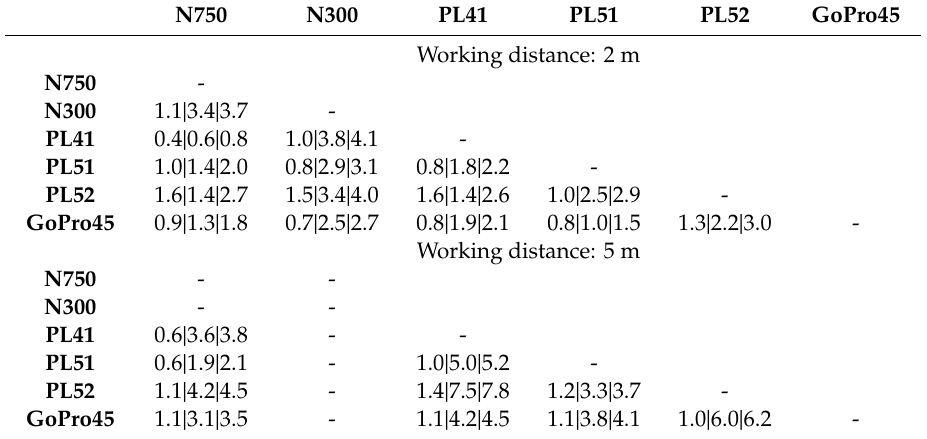
Table 7. Comparison of photogrammetric bundle adjustment (BA) solutions between the di ff